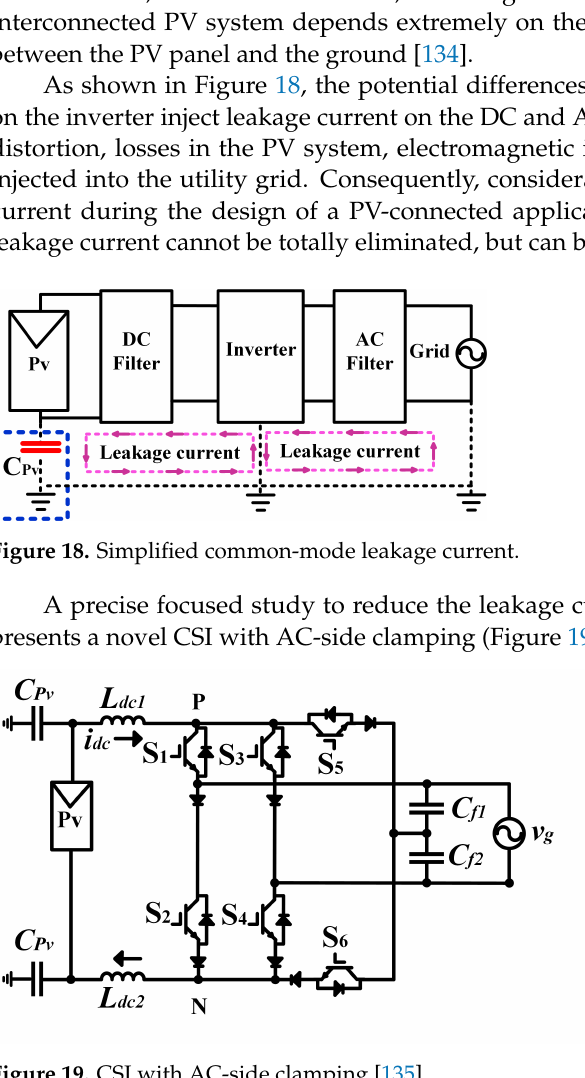
Figure 19. CSI with AC-side clamping